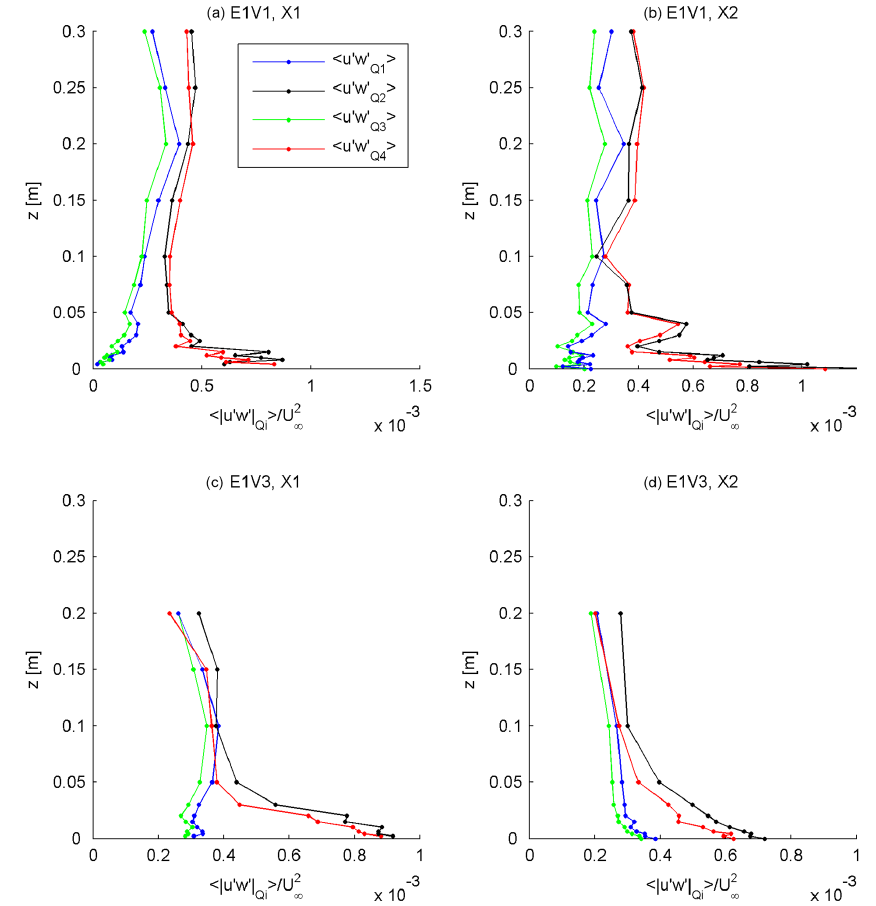
Figure 5. Shear stress contribution of the quadrants for the experimental setups E1V1 and